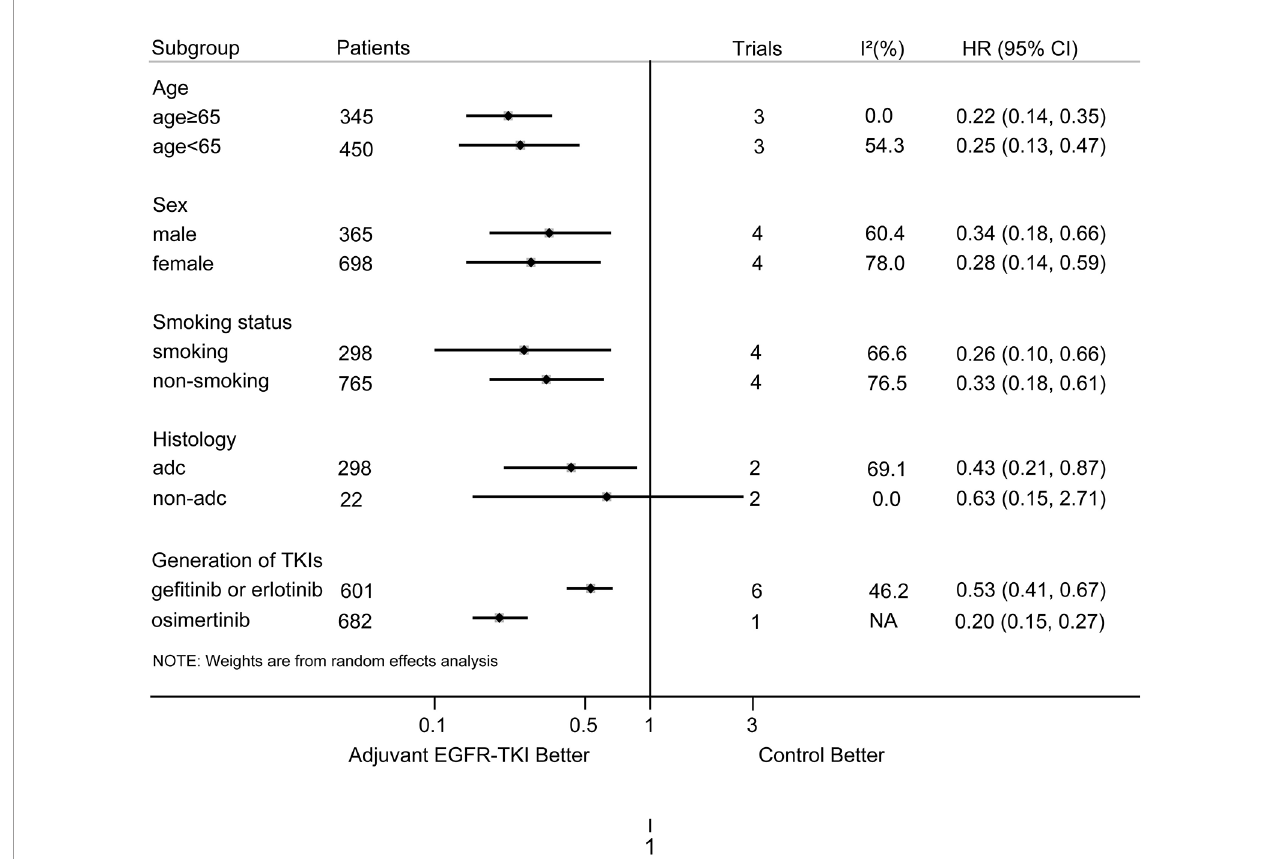
FIGURE 3 | Subgroup analysis on DFS according to age, sex, smoking status, histology, and generation of EGFR-TKIs. NA, not available; adc, adenocarcinoma; non-adc,